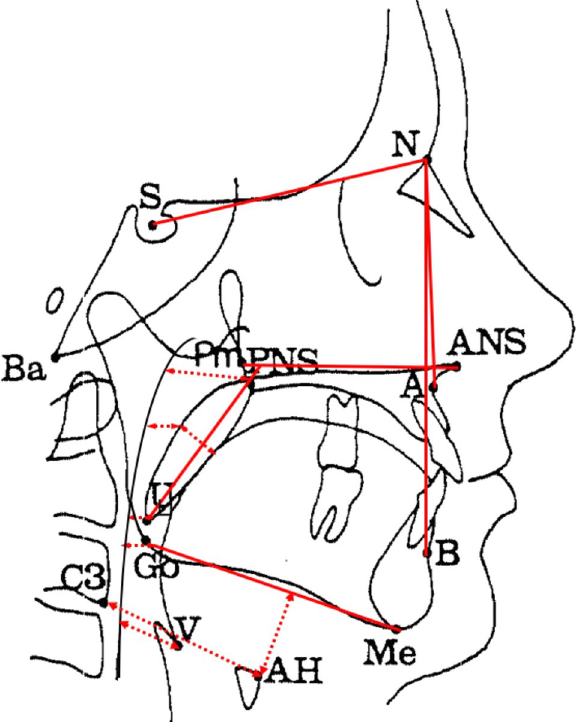
Figure 1. Cephalometric landmarks and linear and angular measurements. S, Sella; N, Nasion; A, subspinale; B, supramentale; AH, Anterior Hyoid; Go, Gonion; Me, Menton; C3, Third Vertebra; PNS, posterior nasal spine; U, Tip of the Uvula; ANS, anterior nasal spine; Pm, Pterygomaxillare; Ba, Basion; V, Vallecula. SNA, smaller angle which is formed by sella(S), nasion(N), and A point; ANB, smaller angle which is formed by A point, nasion(N), and B point. AH ⊥ MP, the perpendicular distance between AH and Go-Me line; AH-C3, the distance between AH and the third vertebra; SPT, maximum width of soft palate which is perpendicular to PNS-U line; PNS-U, the distance between PNS and U; NL/PNS-U, smaller angle between ANS-Pm line and PNS-U line; NAS, nasal airway space, the distance between the intersection of Ba-PNS and posterior pharyngeal wall and PNS; SOAS, superior oral airway space, the distance between the ventral surface of the soft palate and the dorsal surface of the tongue, measured through a point midway between PNS and U, parallel to the line that intersects gonion and menton; MOAS, middle oral airway space, the perpendicular distance between U and posterior pharyngeal wall; IOAS, inferior oral airway space, the distance between the posterior pharyngeal wall and the dorsal surface of the base of the tongue, measured on the line that intersects gonion and menton; HAS, hyoid airway space, the perpendicular distance between V and posterior pharyngeal